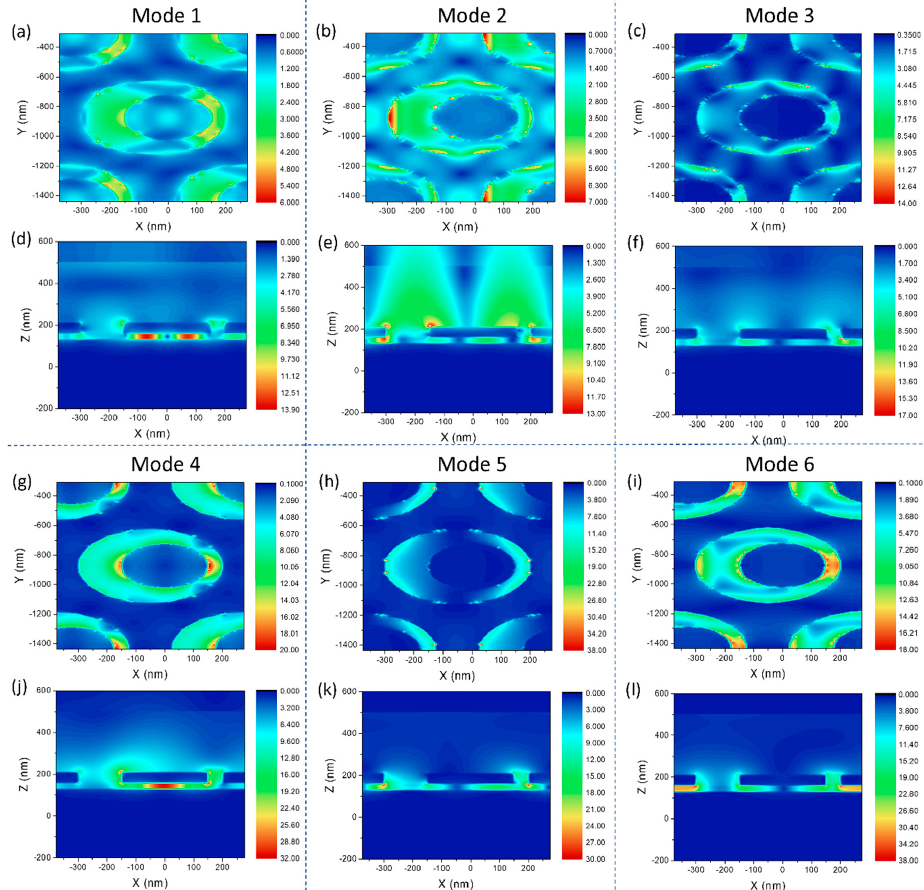
Figure 3. Electric field distribution at the resonance wavelengths of the six modes. ( a ), ( b ), (c), ( g ), ( h ), and ( i ), respectively, are the electric field distributions of six modes (668 nm, 766 nm, 809 nm, 972 nm, 1131 nm, and 1499 nm) on the x–y plane of a single asymmetric ring cavity. ( d ), ( e ), ( f ), ( j ), ( k ), and ( l ), respectively, are the electric field distribution of six modes (668 nm, 766 nm, 809 nm, 972 nm, 1131 nm, and 1499 nm) on the x – z plane of a single asymmetric ring cavity.